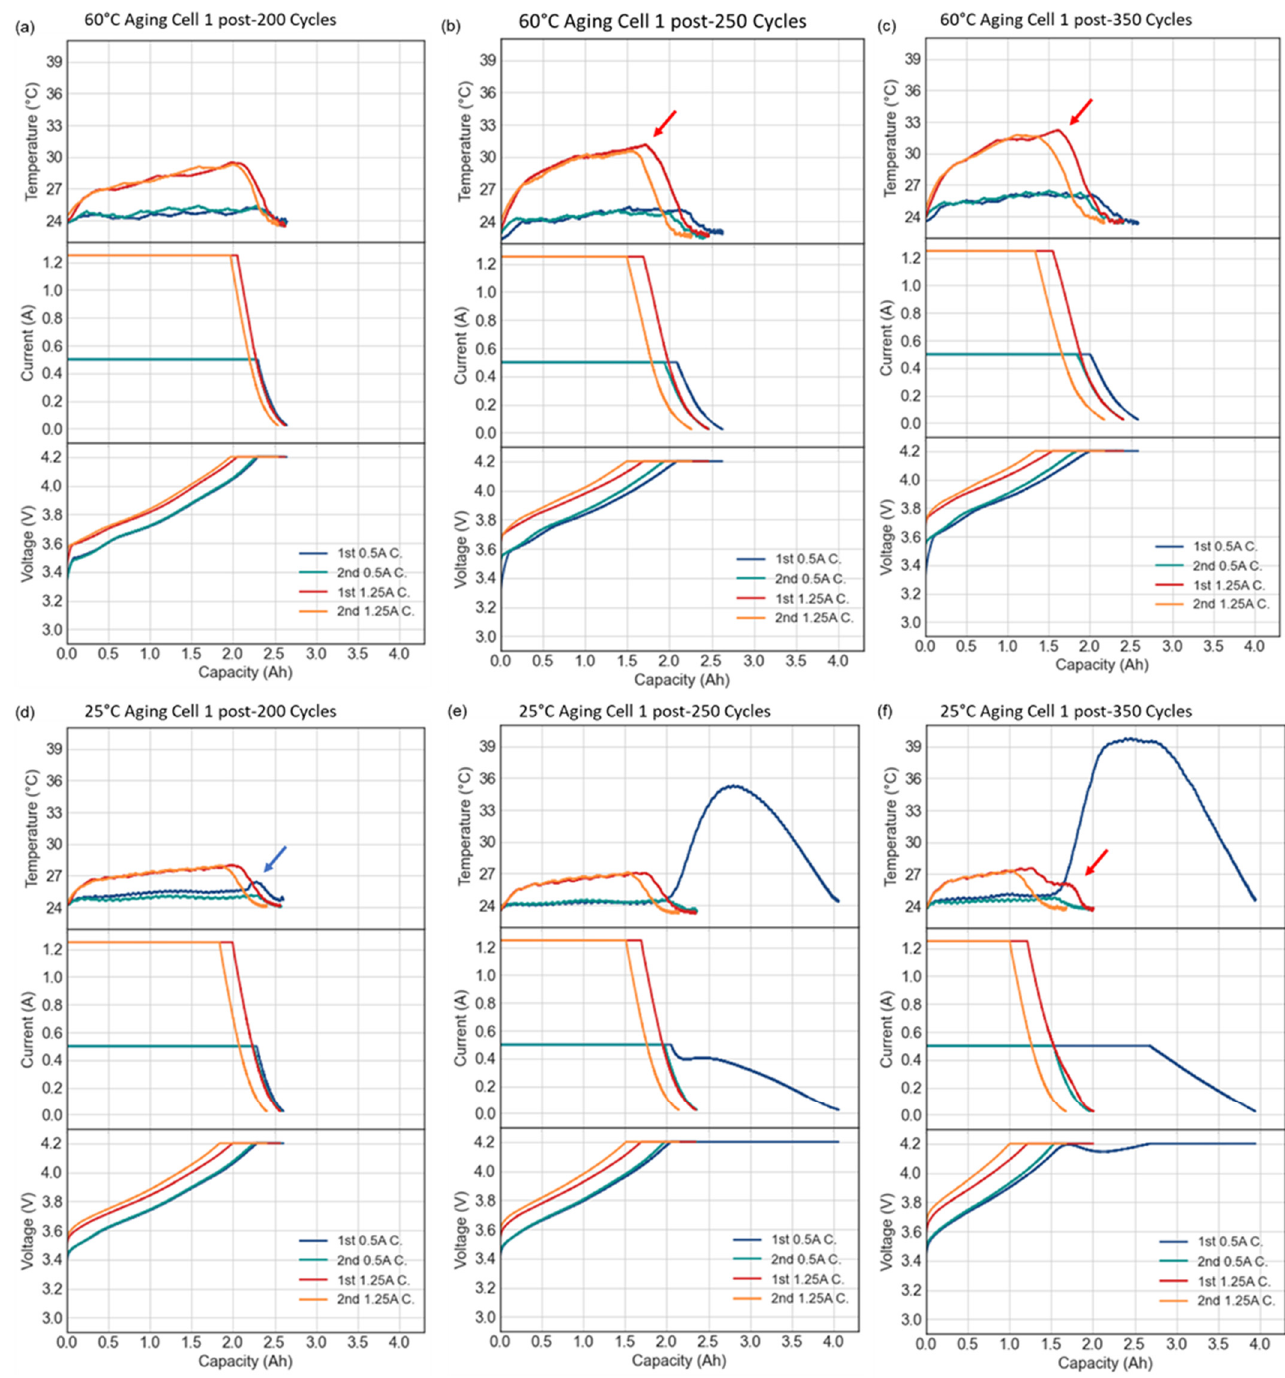
Figure 7. Example room-temperature electrical measurement results of cells aged after cycling at 60 °C (panels a – c ) or after cycling at 25 °C (panels d – f ) after 200, 250, and 300 cycles. The measurements are carried out after resting the cells at room temperature for 1 day and each consists of two 0.5 A cycles and followed by two 1.25 A cycles between 3.0 V and 4.2 V. The blue arrow in ( d ) identifies the slight temperature bump in the first 0.5 A cycle. The red arrows in ( b , c , f ) identify the slight temperature bump in the first 1.25 A cycles.